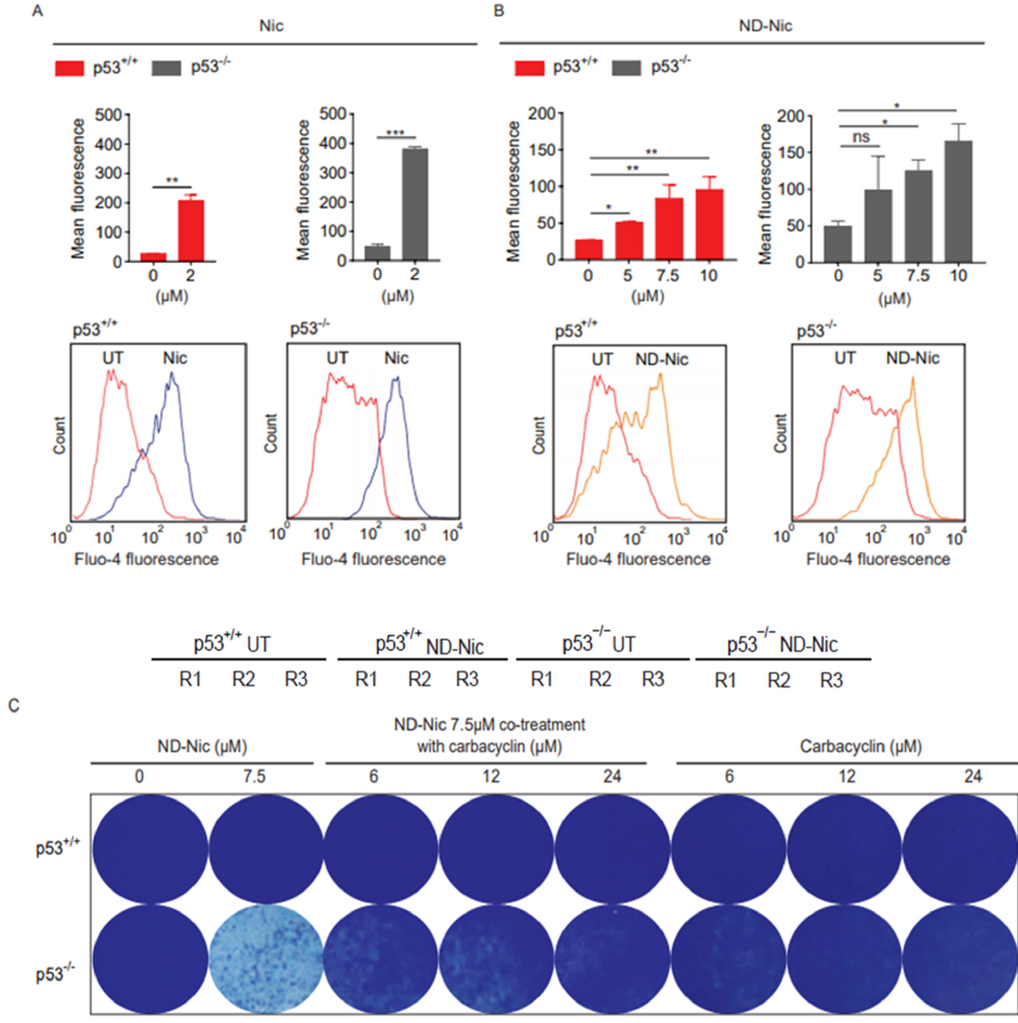
Figure 4. Nitro-deficient niclosamide induces calcium flux independent of p53 status. Calcium flux analysis using Fluo-4, AM was conducted in human colon carcinoma HCT116 p53 +/+ and p53 − / − cells, untreated or treated with ( A ) 2 µ M Nic and ( B ) ND-Nic (5, 7.5, and 10 µ M) for 16 h. Mean fluorescence intensities (Top) were quantified using FlowJo software. (Bottom) FlowJo software plots of calcium flux detected by the shift of Fluo-4 fluorescence in either ( A ) 2 µ M Nic or ( B ) 10 µ M ND-Nic treated HCT116 p53 +/+ and p53 − / − cells. Error bars represent ± SD of at least 3 independent experiments. t -test was used to determine significance (*, p < 0.05; **, p < 0.01; ***, p < 0.001; ns, p > 0.05). ( C ) Crystal violet staining of HCT116 p53 +/+ (Top) and p53 − / − (Bottom) 7 d post recovery from either single treatment with ND-Nic (7.5 µM) or ND-Nic 7.5 µM co-treatment with carbarcyclin (6, 12, and 24 µM) for 48 h. Treatment with carbacyclin alone serves as the negative control. Black scale bar at 37 mm.